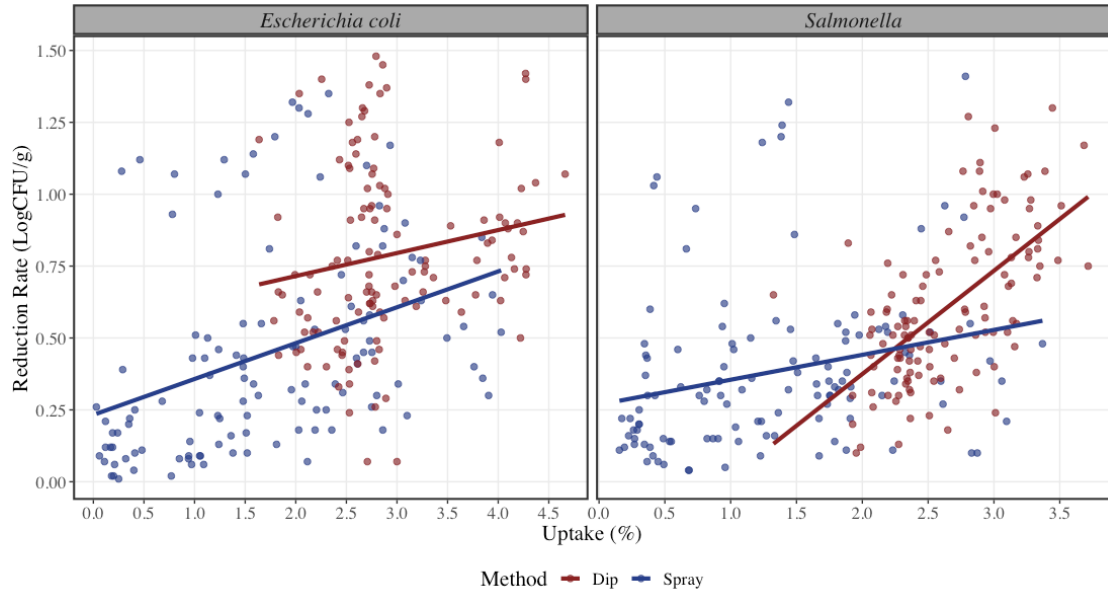
Figure 2. Reduction rate of Shiga-toxin producing Escherichia coli and Salmonella spp. at different